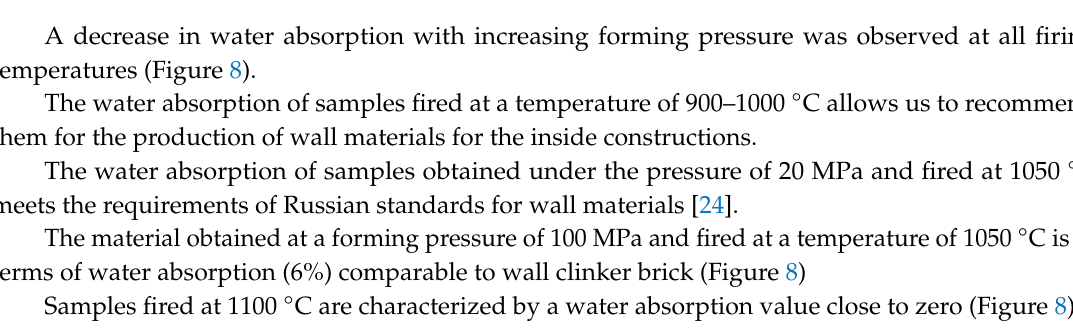
Figure 8. Water absorption versus forming pressure at different firing temperatures.